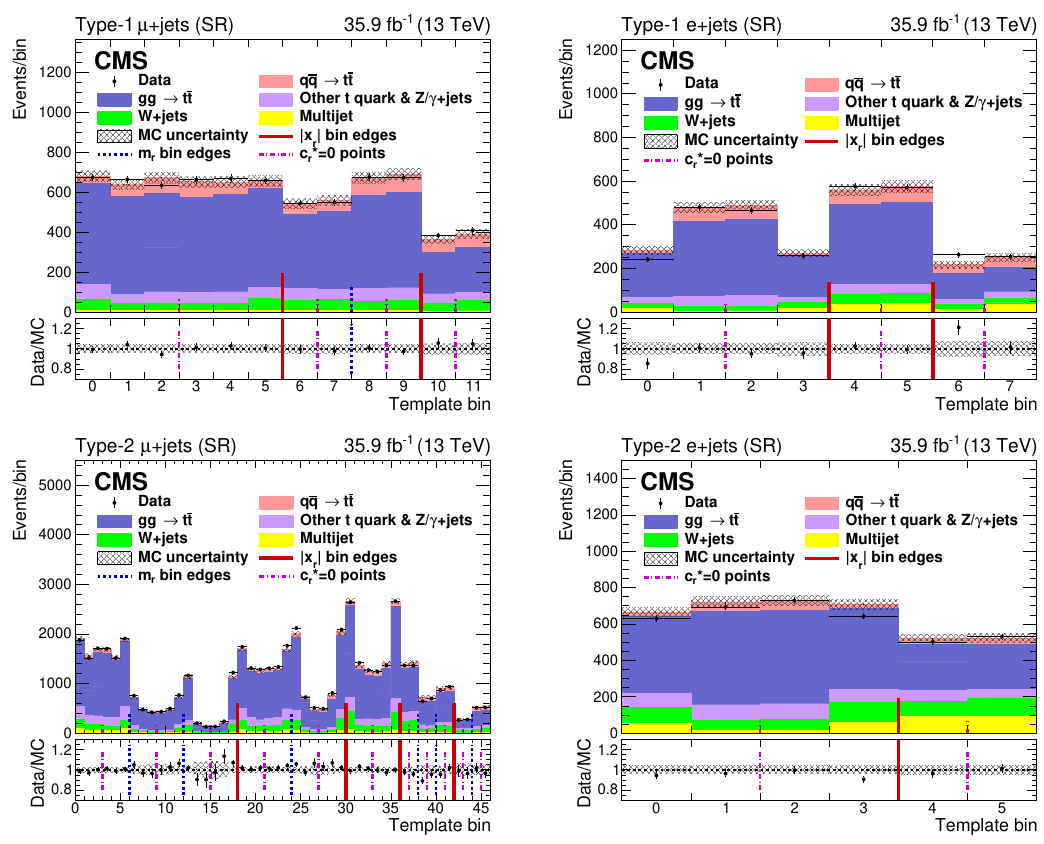
Figure 9 . Comparisons of (cid:12)tted data and MC expectations as a function of template bin number for the A (1) parameter extraction. The plots show events in the type-1 (upper row) and type-2 FB (lower row) m +jets (left column) and e+jets (right column) channels, all summed over lepton charge. The MC uncertainty pictured in the hatched bands represents the total (statistical and systematic) uncertainty. The vertical solid, dashed, and dot-dashed lines indicate the edges of the bins in x m and the midpoints of the c (cid:3) distributions, respectively, corresponding to the binning schemes r listed in tables 3{6 in appendix